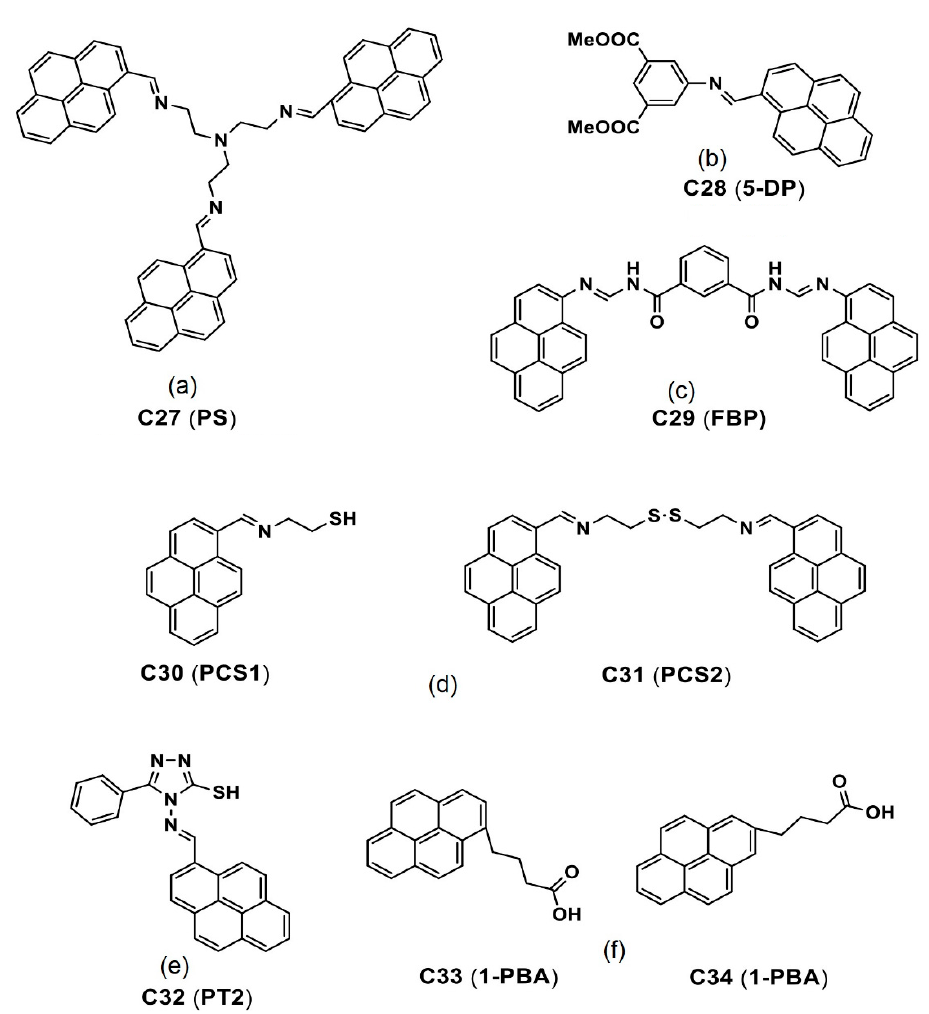
Figure 16. ( a – f ) C27 – C34 are the chemdraw structures of pyrene-conjugated small molecules (Note: the original representation or numbering of the molecules were provided in the brackets along with respective reference numbers).